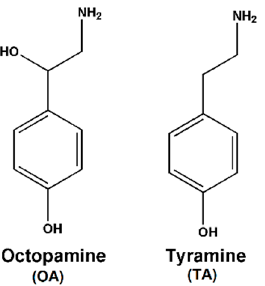
Figure 1. Chemical structures of OA and TA.